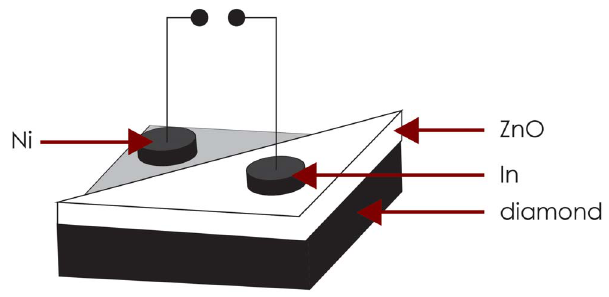
Figure 1. Schematic diagram of ZnO/type IIb diamond hetero-